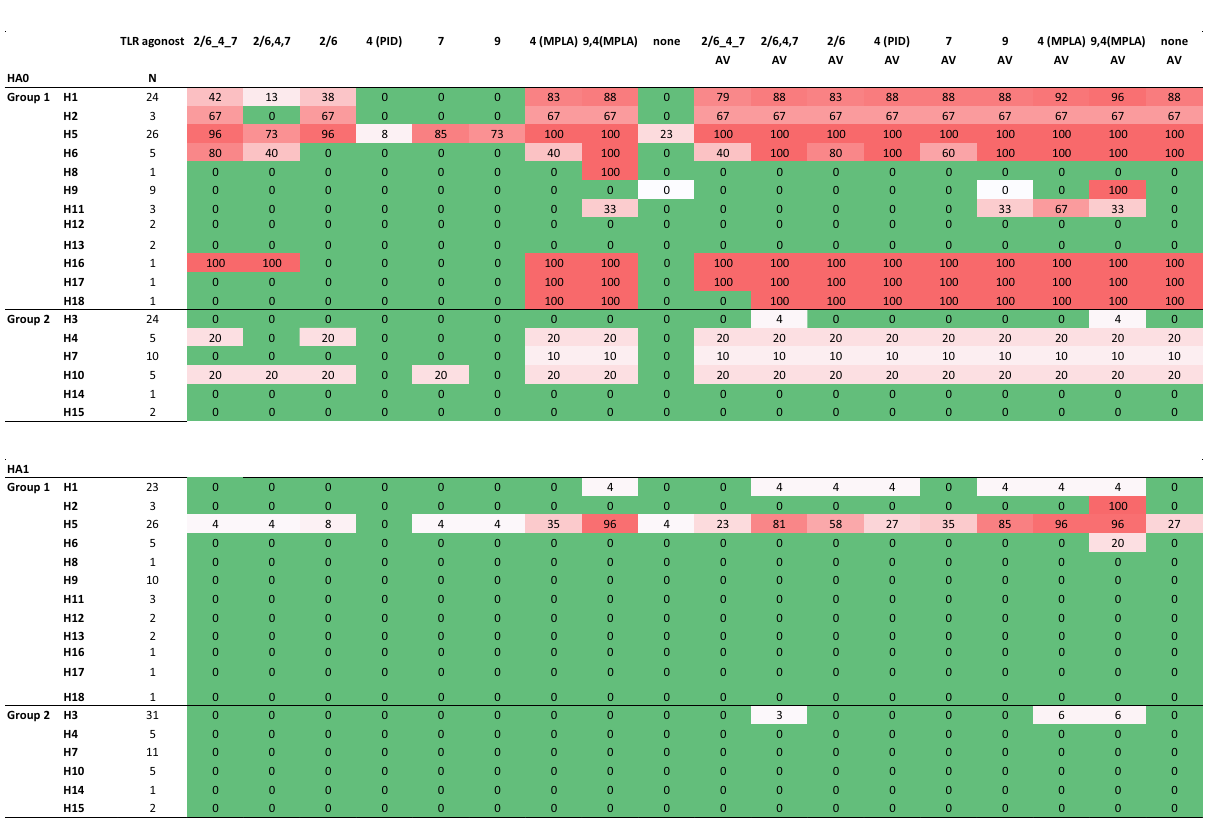
displaying strong IgG1 signals and robust IL-4 SFC numbers. Note this contrasts with the combination TLR9 a/TLR4 a (CpG/MPLA) in the absence of emulsion, which strongly polarizes the response to IgG2c (Th1) and a production of IFN-γ SFCs. Thus, the breadth of the cross-reactive response and polarization can be tuned according to the adjuvant, as summarized in Table 3.